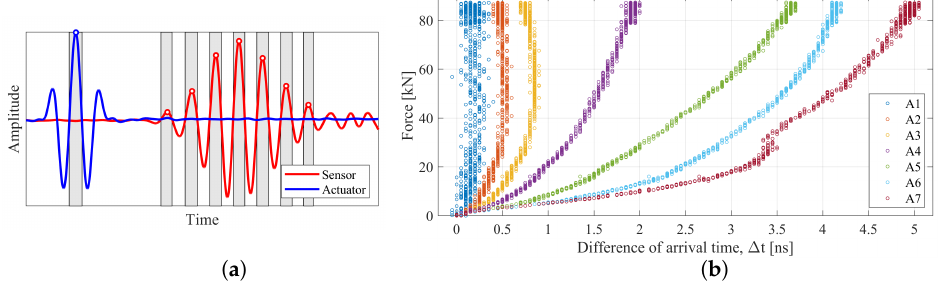
Figure 7. Arrival time and amplitudes: ( a ) an example of how they were determined; ( b ) differences of arrival time in the P1